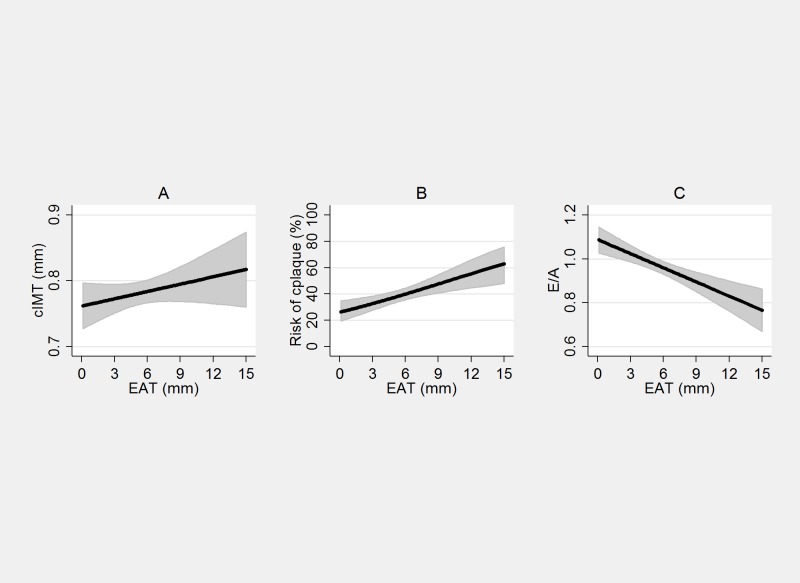
Association between EAT and cardiovascular parameters.EAT (unit) and cIMT (panel A), coefficient β: 0.005, (95% C.I. 0.001, 0.009), p = 0.007, EAT and cplaques (panel B) O.R. 1.10 (95%C.I. 1.04–1.18), p<0.0001, EAT and E/A (panel C) coefficient β -0.02, (95%C.I. -0.03, -0.01), p = <0.0001).